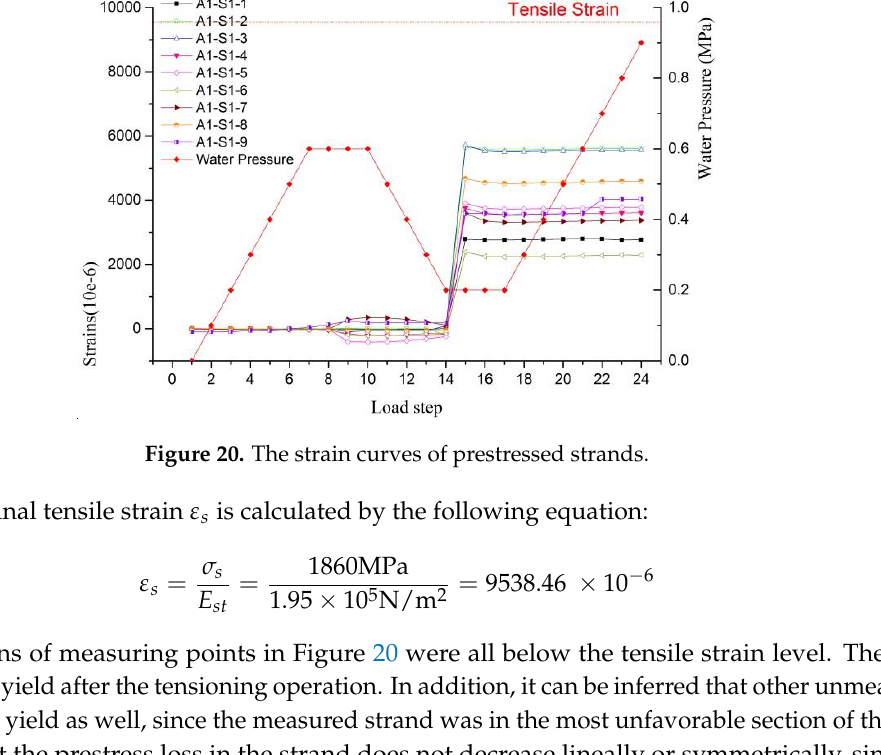
Figure 19. A spot photo of the test pipe after tensioning.